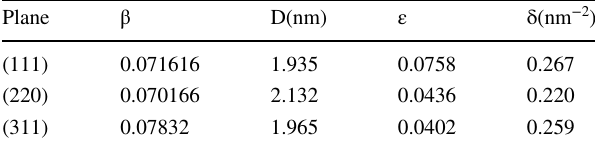
Fig. 1 Plot of a The X-ray diffraction pattern, and b lnβ vs. ln (1/ cosθ) of CdS sample